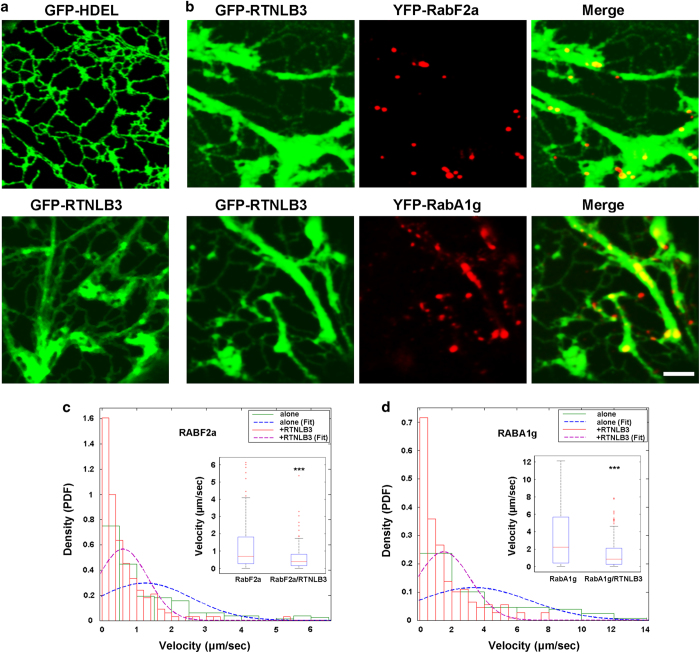
Disruption of ER network integrity compromises endosome velocity. (a, b) GFP-HDEL, GFP-RTNLB3, YFP-RabF2a and YFP-RabA1g were transiently expressed in tobacco leaf epidermal cells. GFP-HDEL reveals a typical ER network with tubules and cisternae; however, expression of GFP-RTNLB3 causes deformation of the ER network. Scale bars, 5 μm. (c, d) Streaming velocity measurements of 165 endosome organelles labeled by YFP-RabF2a (c) and 218 endosomes labeled by YFP-RabA1g (d) in tobacco epidermal cells in the absence (solid green lines) or in the presence of overexpressed GFP-RTNLB3 (solid red lines) were calculated from kymographs generated in ImageJ (v1.49 h). Endosome movement is expressed as histograms and probability density function (PDF) of the velocity distributions, which were fitted (blue and magenta dashed lines) using distribution tool (Matlab). Inset in c and d display the average velocity of the relative endosomes. Statistical analysis was performed using Student’s t-test (***P<0.0001). ER, endoplasmic reticulum.